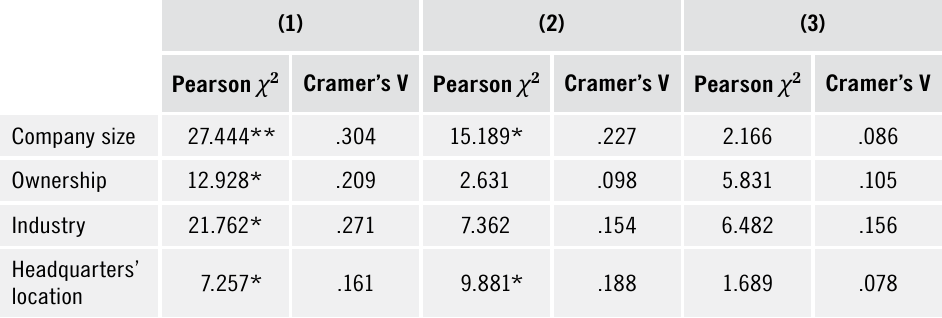
Table 4. Relationship between the dependent and categorical independent variables (1) (2)